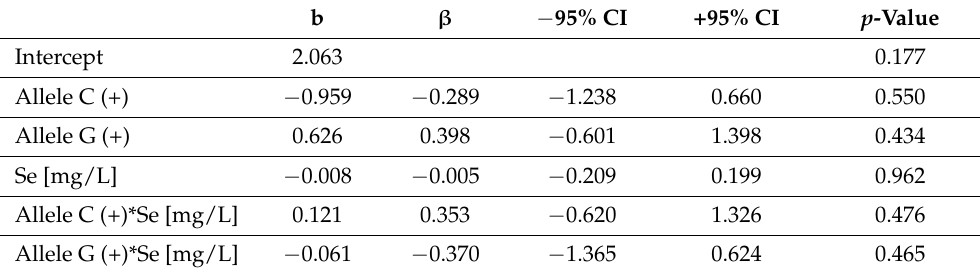
Table 8. Dependent variable: the BDI score (with moderation).